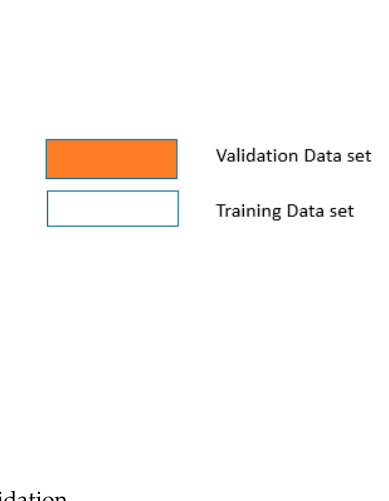
Figure 5. 5-fold Figure 5. 5-fold cross-validation.